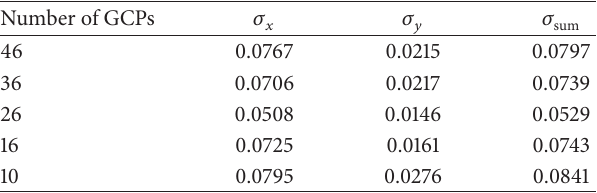
Table 2: The assessment of accuracy for geometric correction (unit: